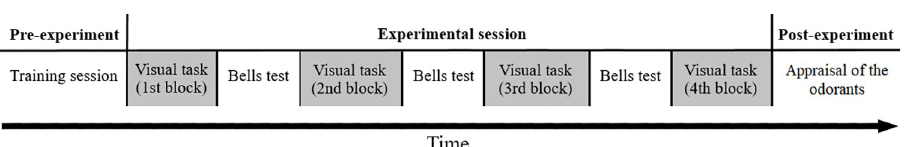
Fig 2. Timeline of the experimental procedure. Timeline showing the procedures conducted in pre-experiment, experimental session and post-experiment moments. The stages of the experimental session in which an odor condition was present (butyric acid, isoamyl acetate, lemongrass or no odor) are marked in